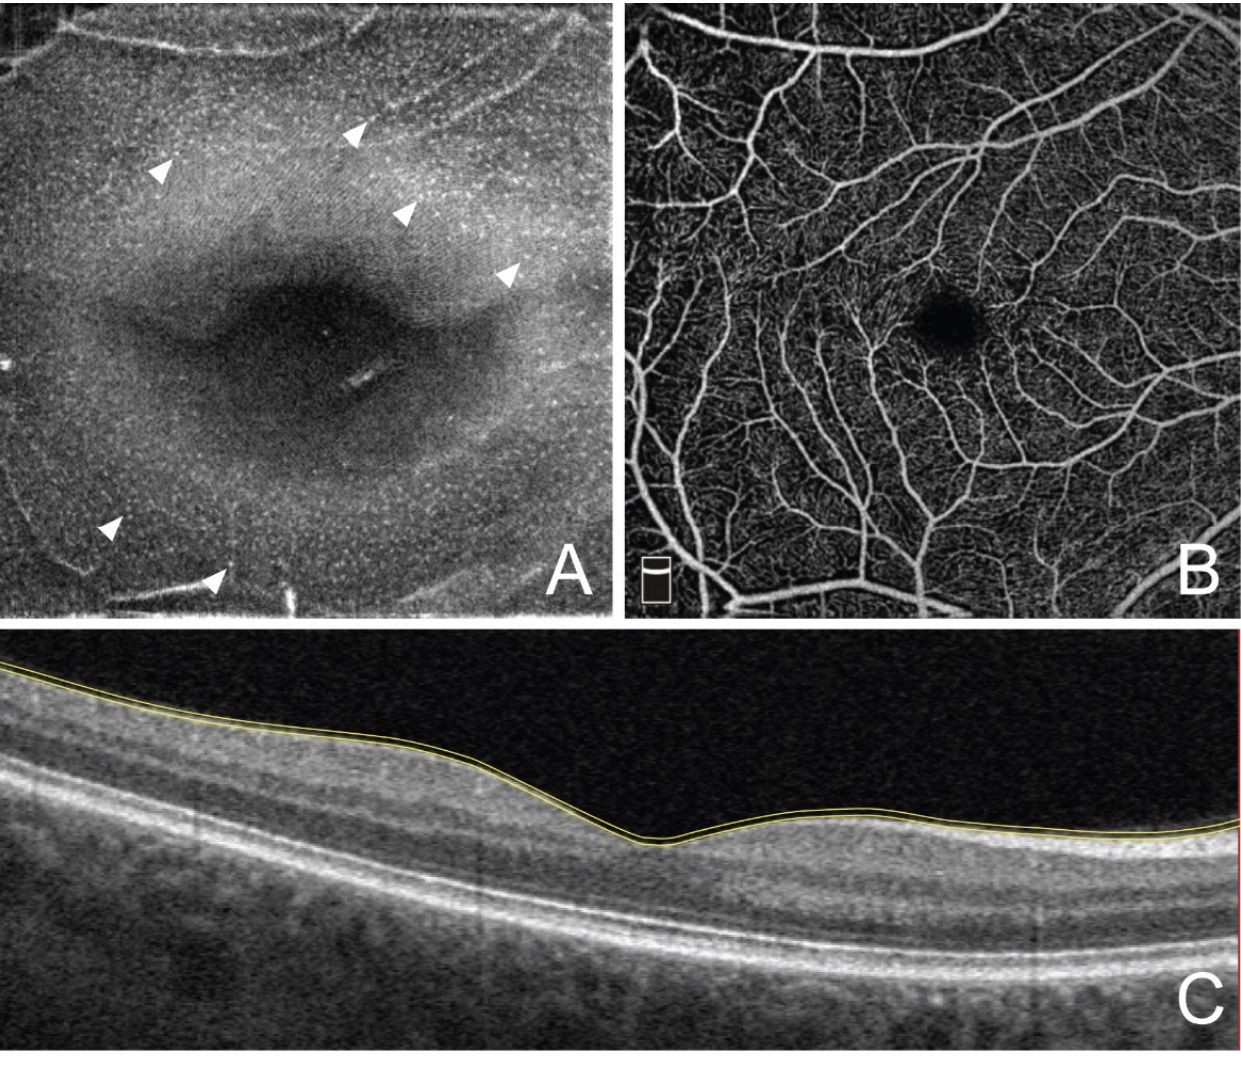
Figure 1. Representative example of visualization of retinal macrophage-like cells using 9-µm structural en face projection between two segmentation lines of the inner limiting membrane with − 9 µm and 0 µm offset. ( A ) Structural en face optical coherence tomography angiography (OCTA) projection. Arrowheads indicate individual macrophage-like cells. ( B ) En face OCTA projection of superficial capillary plexus slab. ( C ) Cross-sectional OCT scan trough the center of the macula. Yellow lines represent segmentation lines of inner limiting membrane with 0 and − 9 µm o ff set.